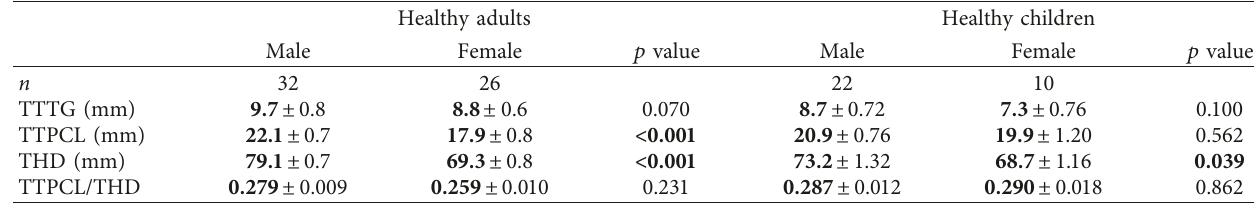
Table 3: Gender-specific results for the TTTG, TTPCL, THD and TTPCL/THD in the healthy study